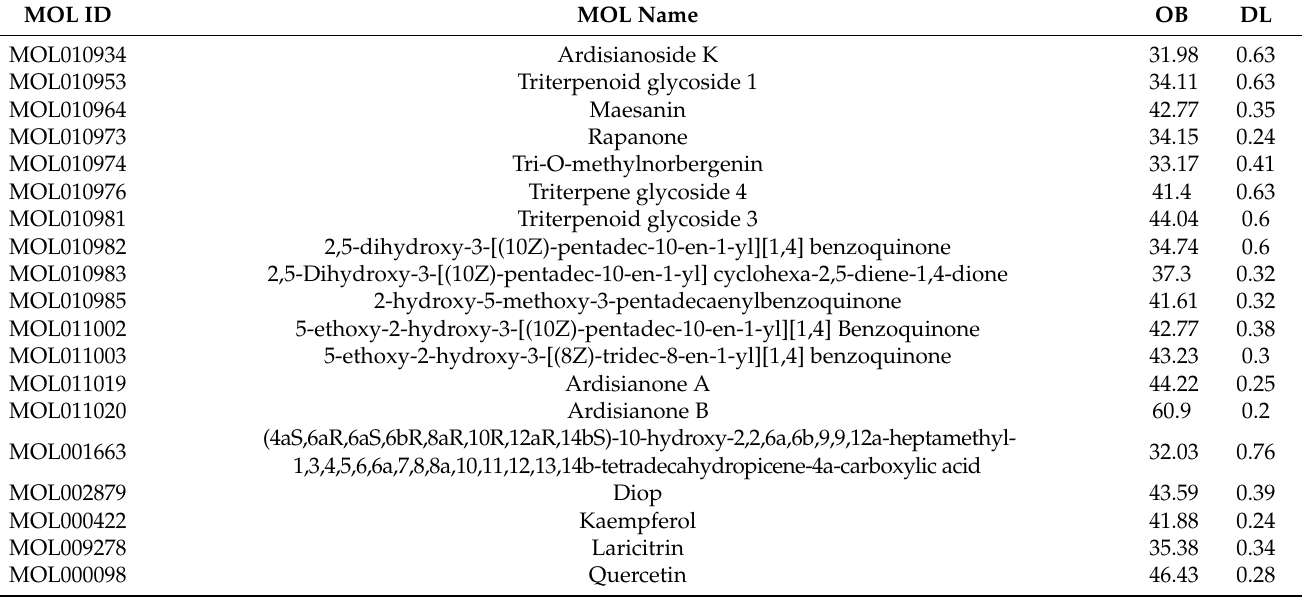
Table 1. Basic information on the active compounds of Japanese Ardisia